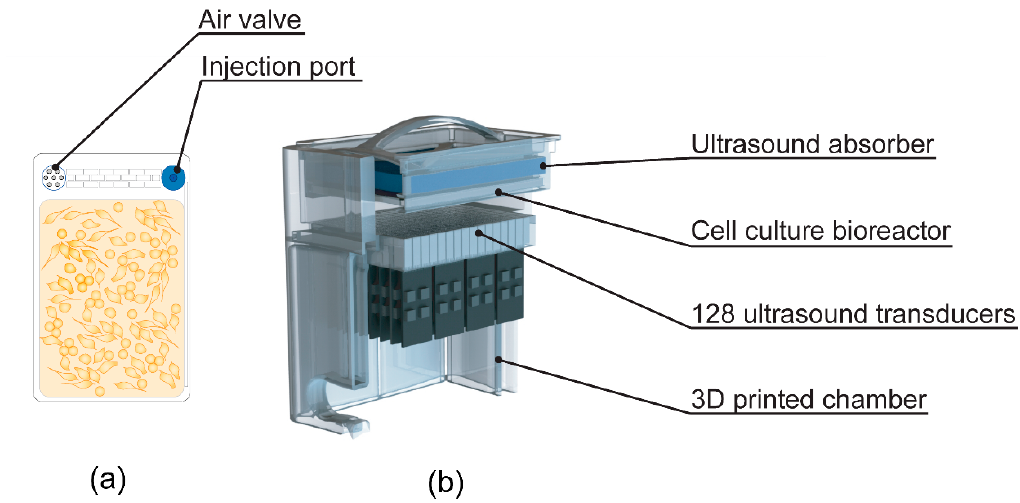
Figure 1. ( a ) Drawing of cell culture bioreactor (Petaka) used for culturing of cells prior to ultrasound (US) treatment; ( b ) cutaway of custom-made US treatment chamber used for US treatment of cells (adapted from [22], Pharmaceutics, 2020).